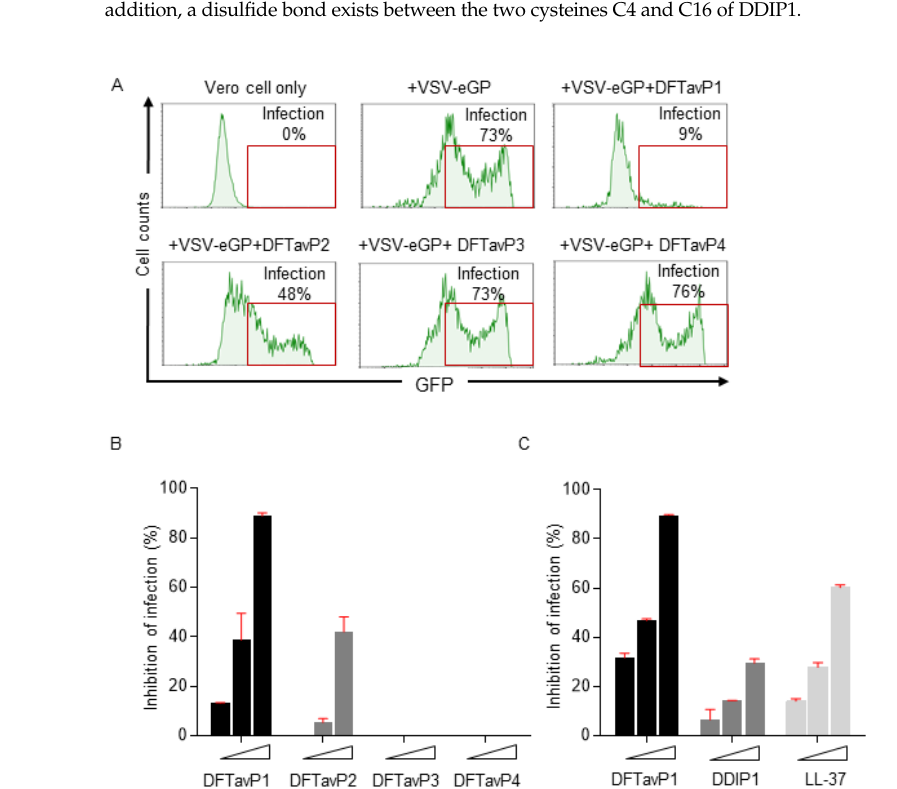
Figure 4. Designed AMPs inhibited the infection of pseudo-EBOV virion in Vero cells. ( A ) AMPs inhibited pseudo-EBOV (VSV-eGP) infection in Vero cells. Vero cells were pretreated with individual AMPs at 10 µ M for 2 h before VSV-eGP viruses were added. After 24 h of culture, Vero cells were harvested for flow cytometry analysis to measure viral infection. Percentages of GFP-positive cells represent percentages of cells infected with VSV-eGP. ( B ) DFTavP1 and its derivatives inhibited pseudo-EBOV (VSV-eGP) infection in Vero cells in a dose-dependent manner. Since AMPs usually inhibit microbes at micromolar, Vero cells were pretreated with individual AMPs (at 2.5, 5, or 10 µ M) for 2 h before VSV-eGP viruses were added. After 24 h of culture, Vero cells were harvested for flow cytometry analysis to measure viral infection. ( C ) DFTavP1, DDIP1, and LL37 inhibited pseudo-EBOV (VSV-eGP) infection in Vero cells in a dose-dependent manner. Vero cells were pretreated with individual AMPs (at 2.5, 5, or 10 µ M) for 2 h before VSV-eGP viruses were added. After 24 h of culture, Vero cells were harvested for flow cytometry analysis to measure viral Table 1. Database-designed antiviral peptides and their properties.